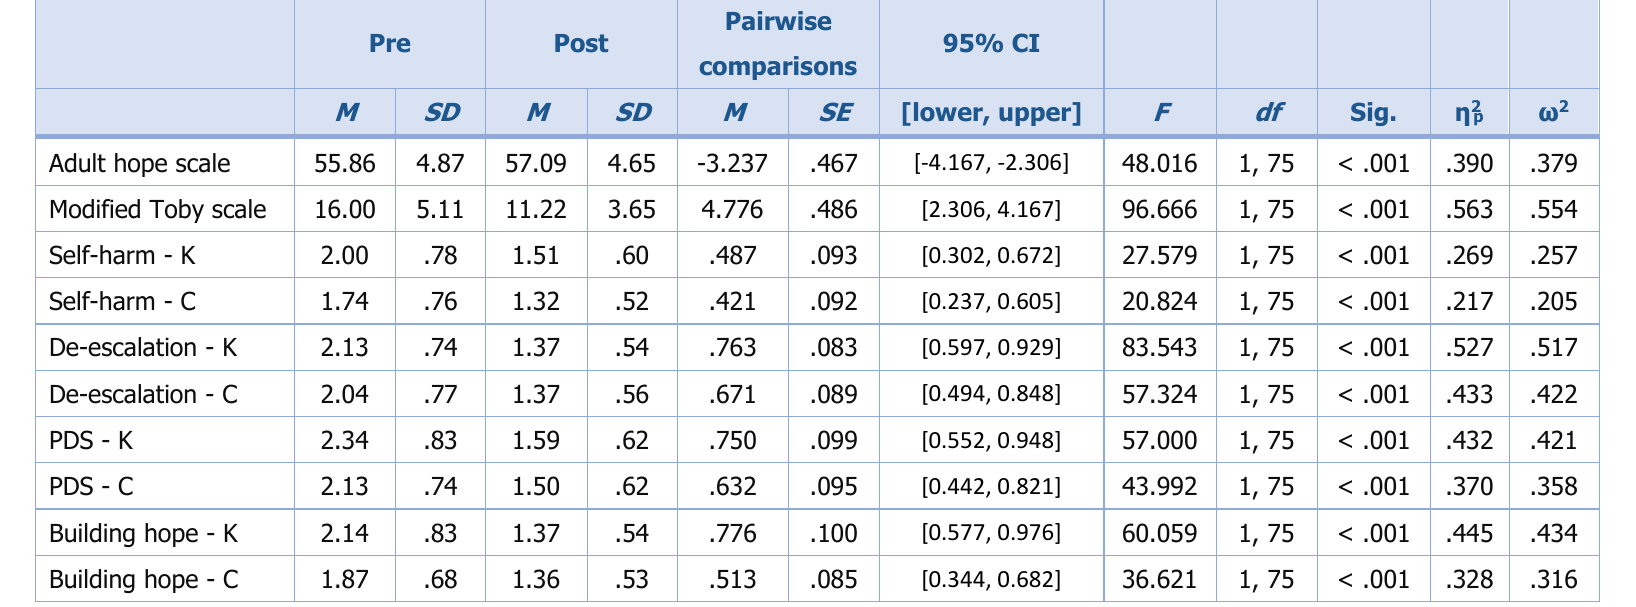
Table 2. Repeated Measures ANOVA Results by Instrument